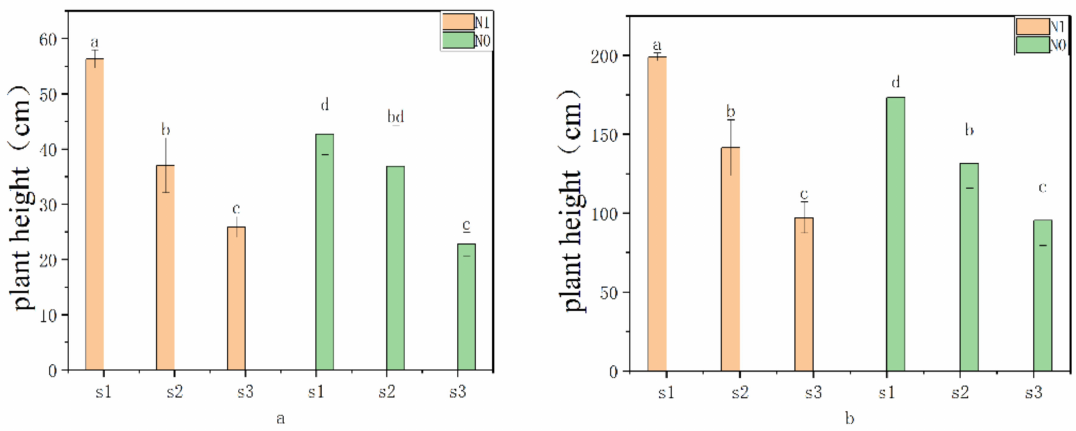
Figure 2. Effects of different nitrogen (N) and salt (S) treatments on plant height at the stages of twelfth leaf (V12, ( a )) and tasseling (VT, ( b )). Different letters indicate statistically significant ( p < 0.05) differences between the treatments using a Tukey post hoc test. N1 is nitrogen application, and N0 is no nitrogen application. S1, S2 and S3 are the soil salinity concentrations of 0%, 0.1% and 0.25%, respectively.